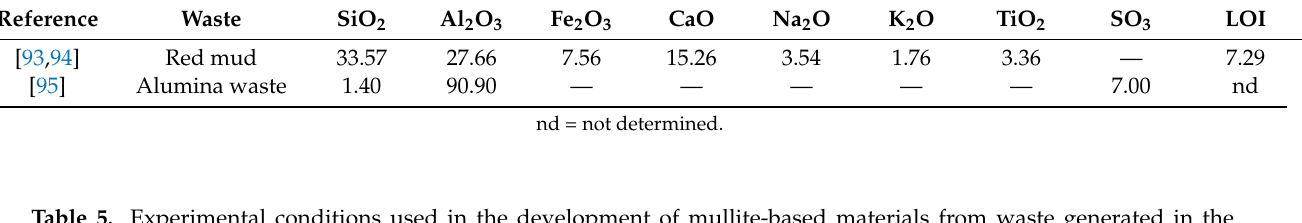
Table 5. Experimental conditions used in the development of mullite-based materials from waste generated in the Bayer